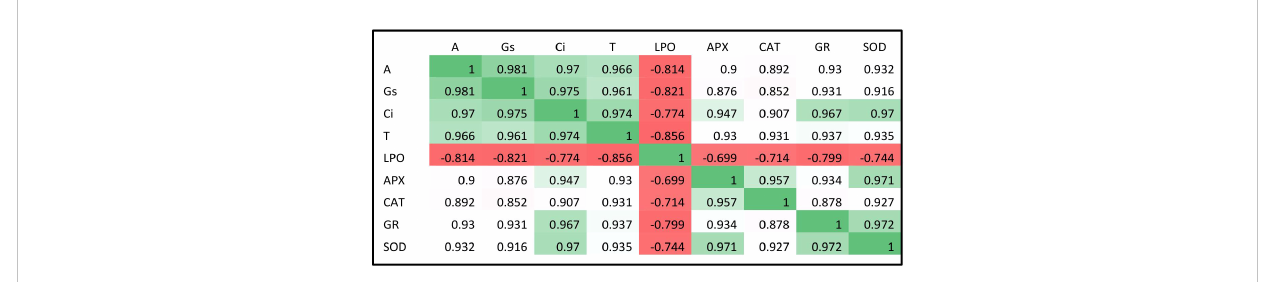
FIGURE 7 Pearson ’ s correlation coef fi cient for physiological and biochemical parameters of two varieties of Hyacinth bean at EO 3